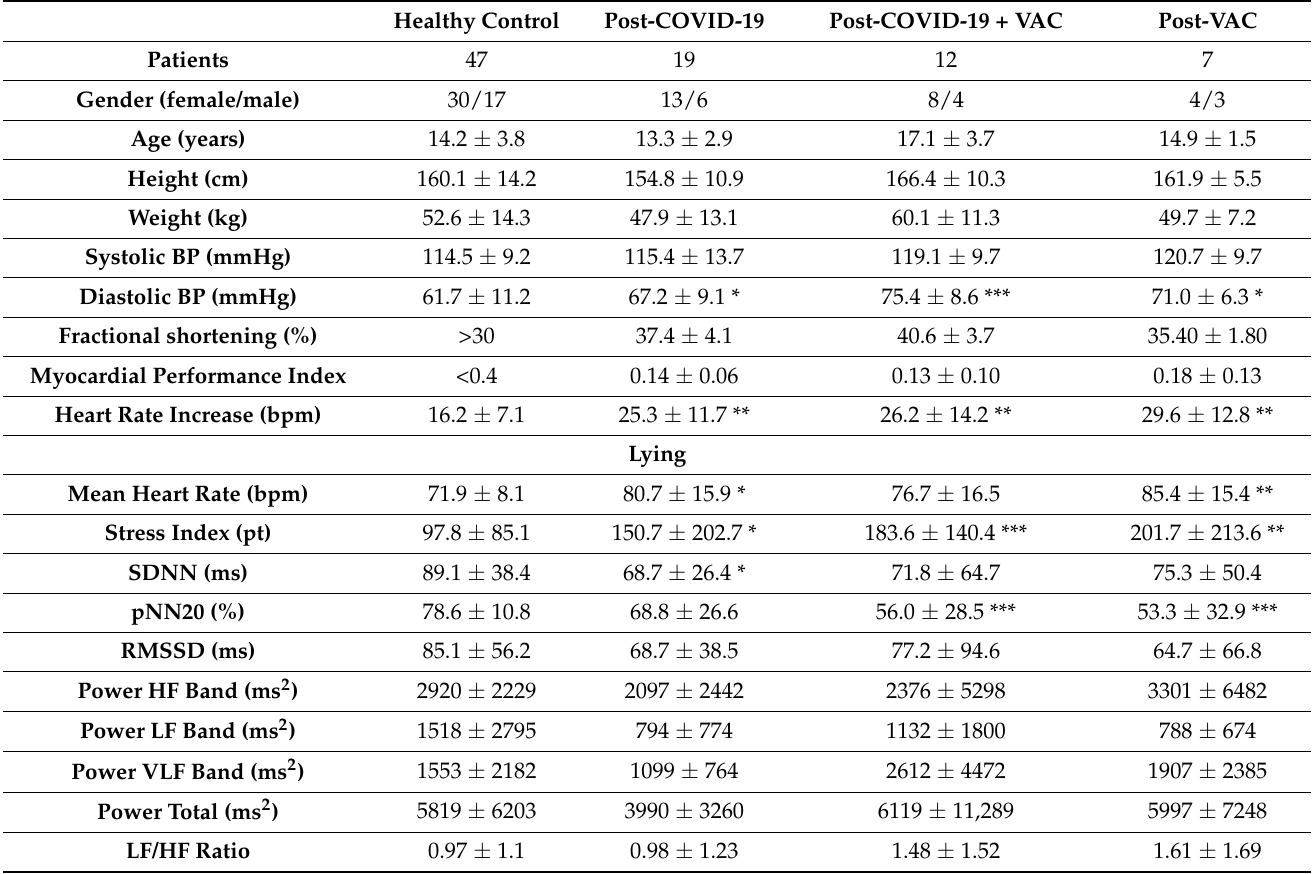
Table 1. Basic data and HRV analysis of the active standing